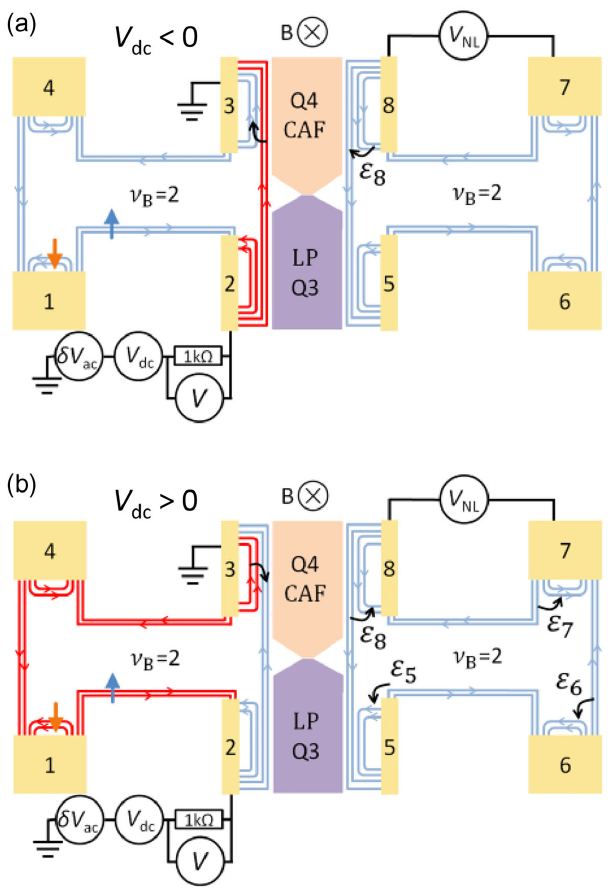
FIG. 2. The nonlocal differential voltage measurement setup corresponding to negative (a) and positive (b) dc bias conditions, respectively. We apply a varying dc bias V and a small ac bias dc ¼ 10 μ V, f ¼ 17 Hz) between two contacts on the left side ( δ V ac of the device and measure a nonlocal ac differential voltage δ V NL on the right side of the device. A 1 k Ω resistance is used to monitor the ac current. Electrons riding on edge states departing from a negatively (positively) biased contact acquire a high (low) chemical potential and are represented in red (blue) lines with the chirality given by the magnetic field. Blue and orange arrows indicate the polarization of spin in the bulk and near the contacts, respectively, where heavy doping by the Si back gate gives rise to additional edge states. SWs are emitted by contact 3 in both bias configurations. ε indicates chemical potential redistribution at a n contact caused by magnon